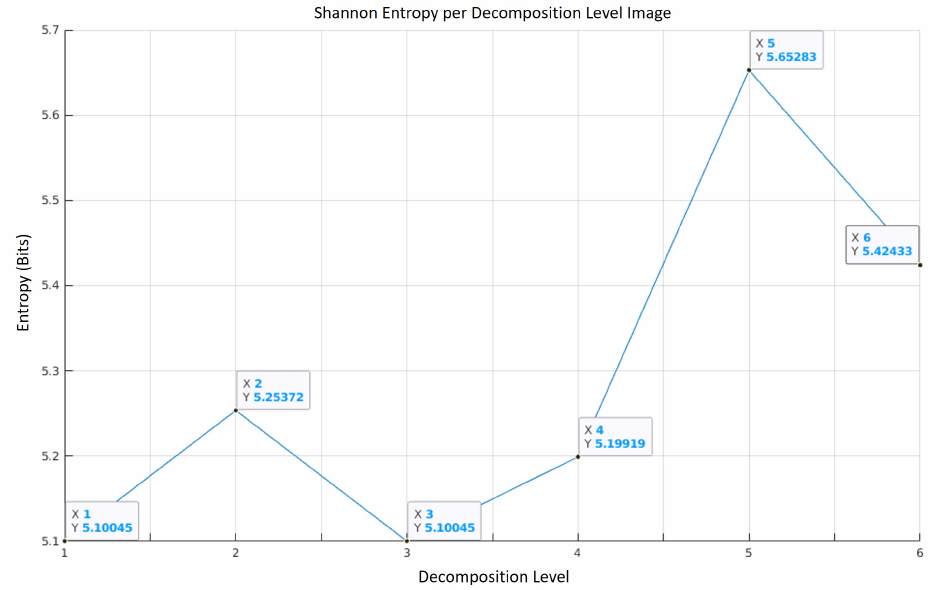
Figure 5. Entropy per decomposition level where vertical and horizontal components are added and normalised using the test image from Figure